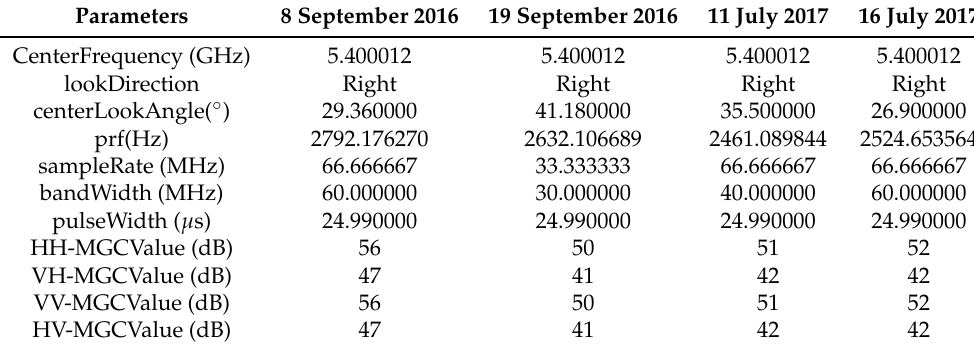
Table 1. The working parameters of GaoFen-3 (GF-3) for the calibration tests. MGC, manual gain